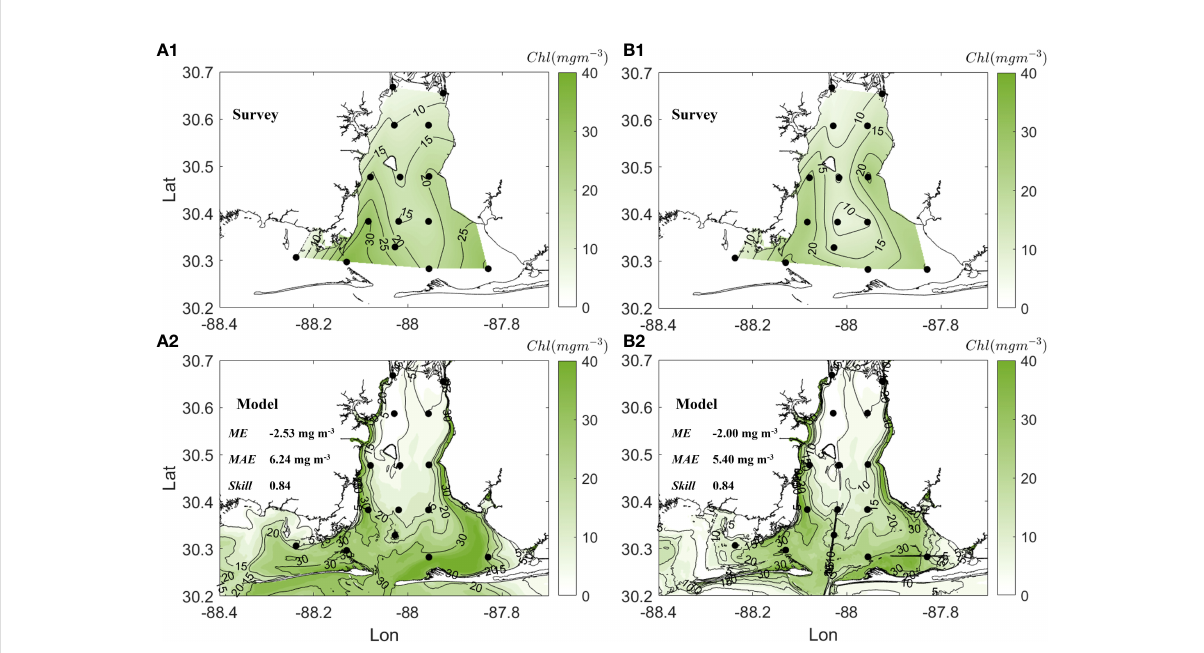
FIGURE 5 Spatial patterns of chlorophyll (Chl) concentration during April 22-23. Figure includes (A.1) Chl at surface, (A.2) modeled surface Chl with ME, MAE, and Skill, (B.1) Chl at 1.5 m below the surface, (B.2) modeled Chl at 1.5 m below the surface with ME, MAE, and Skill. Black circles in all panels denote CTD